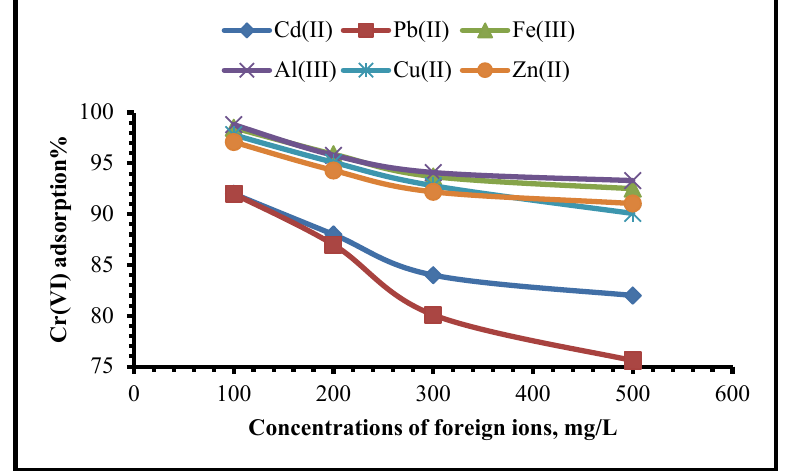
Figure 13. Influence of foreign cations upon the adsorption efficiency of Cr(VI) using TIHP adsorbant.